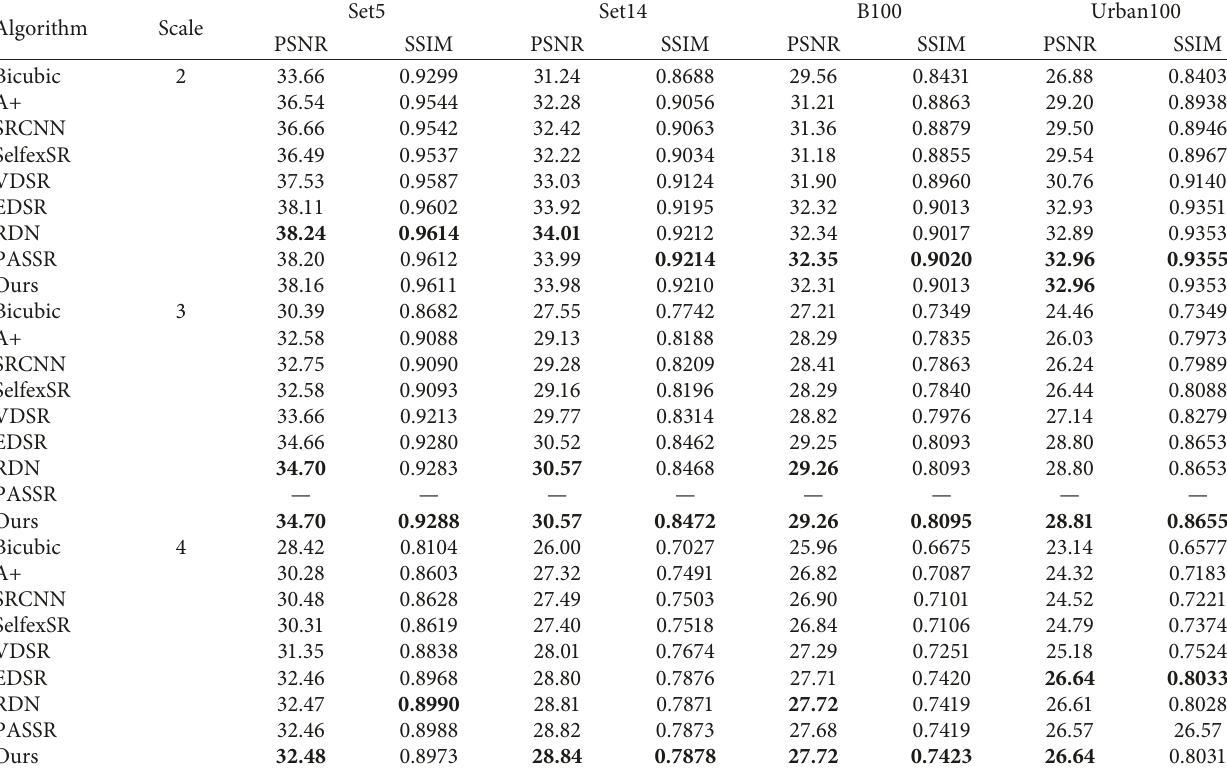
Table 2: Average PSNR/SSIM for scale factor 2, 3, and 4 on datasets Set5, Set14, B100, and Urban100. Bold indicates the best performance.